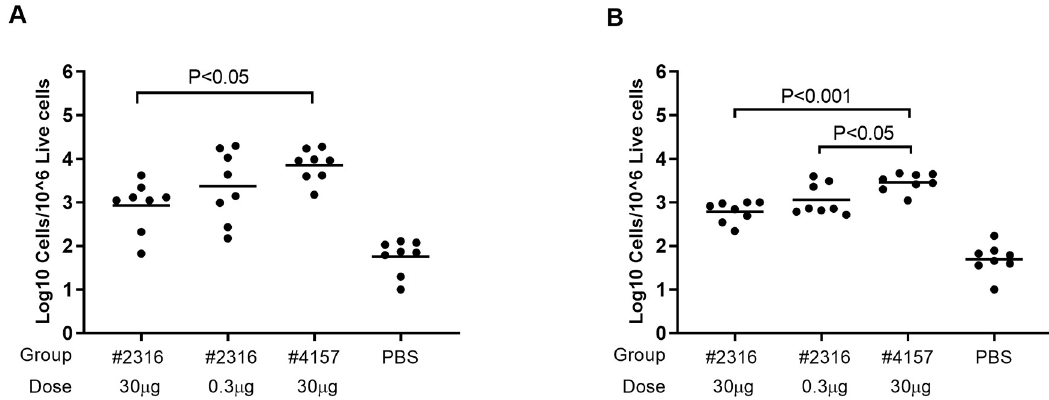
Fig 3. Increased GC B cell expansion after boost-immunization with a non-protective UFV#4157 immunization. Frequencies of cells binding to both FL H1#5070-PE and FL H1#5070-APC conjugates (HA+) among GC (GL7+CD95+) B cells (A) and non-GC (GL7-CD95-) B cells (B) in iliac lymph nodes were measured 4 days post-boost (day 25) in mice (n = 8 per time-point per cohort) vaccinated with 30 μ g alum-adjuvanted FL H1#2316, 0.3 μ g alum-adjuvanted FL H1#2316, 30 μ g alum-adjuvanted UFV#4157 or alum-adjuvanted PBS. Each symbol represents one animal while group means are indicated by a horizontal bar. Statistical comparisons are made by comparing group means of the immunized groups in a one-way ANOVA, corrected for multiple comparisons using Tukey’s statistical hypothesis